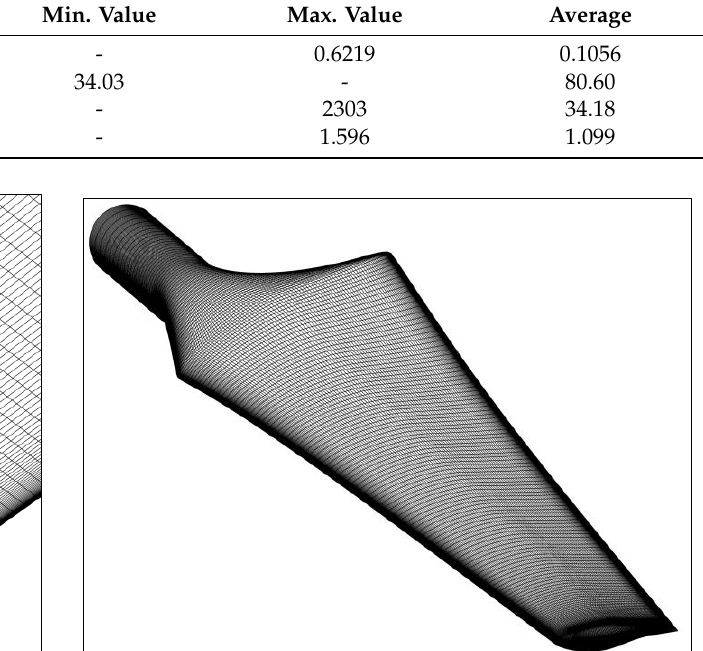
Figure 5. Blade surface mesh.